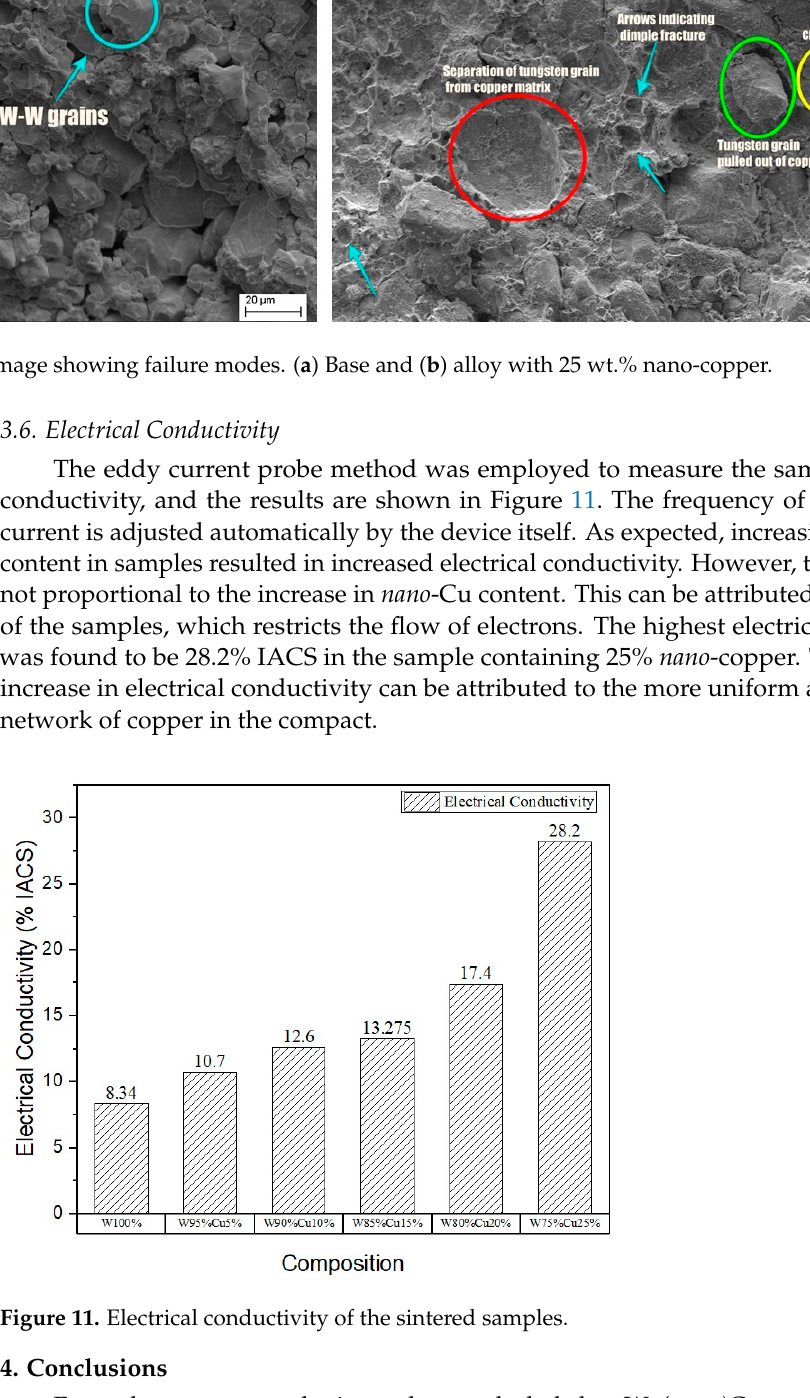
Figure 9. Scanning electron microscope (SEM) images of the fractured surface of samples tested for tensile strength. ( a )